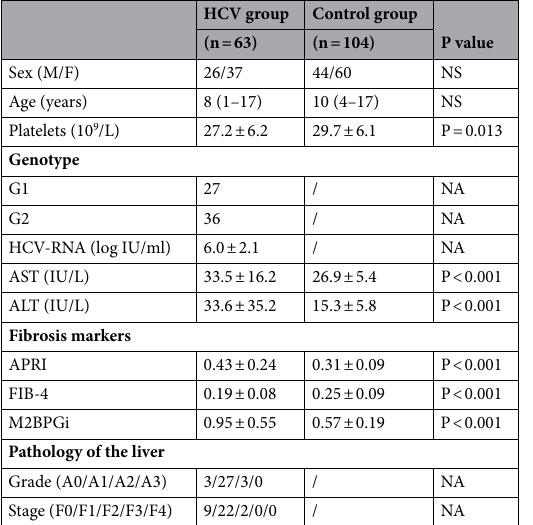
Table 1. Baseline characteristics of HCV patients and control children. NS not significant, NA not